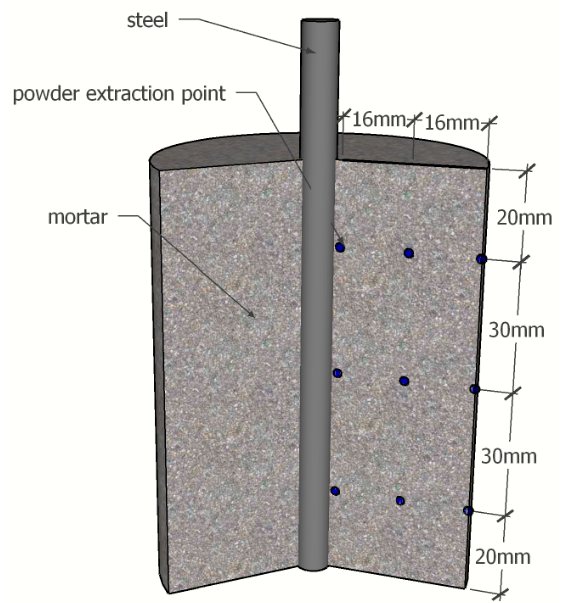
Figure 3. The location of powder extraction.